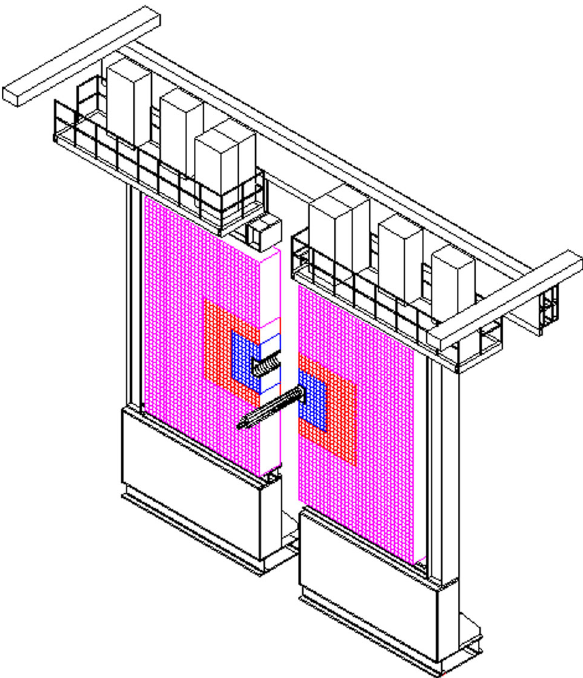
Fig. 1 Theelectromagneticcalorimeter3dviewfrombehindthedetec- tor towards the interaction point [14]